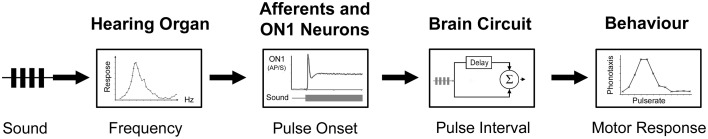
Schematic diagram of serial filter processes in the cricket auditory pathway. At each stage, the response specificity is enhanced. Left to right: frequency tuning of the tympanic membrane response is based on biophysical filter mechanisms in the hearing organ; the detection of sound pulses is supported by the phasic-tonic response properties of auditory afferents and by reciprocal inhibition at the level of thoracic interneurons; the pulse rate is processed in the brain by a delay line coincidence detecting circuit, driving feature detector neurons that preferentially respond to the species-specific pulse rate. In addition, the feature detection circuit may modulate a reactive non-selective steering pathway at the time scale of the chirp rate (not shown). Finally, phonotactic walking behavior is tuned to sound pulses of the calling song carrier frequency presented at the species-specific pulse duration and pulse interval.